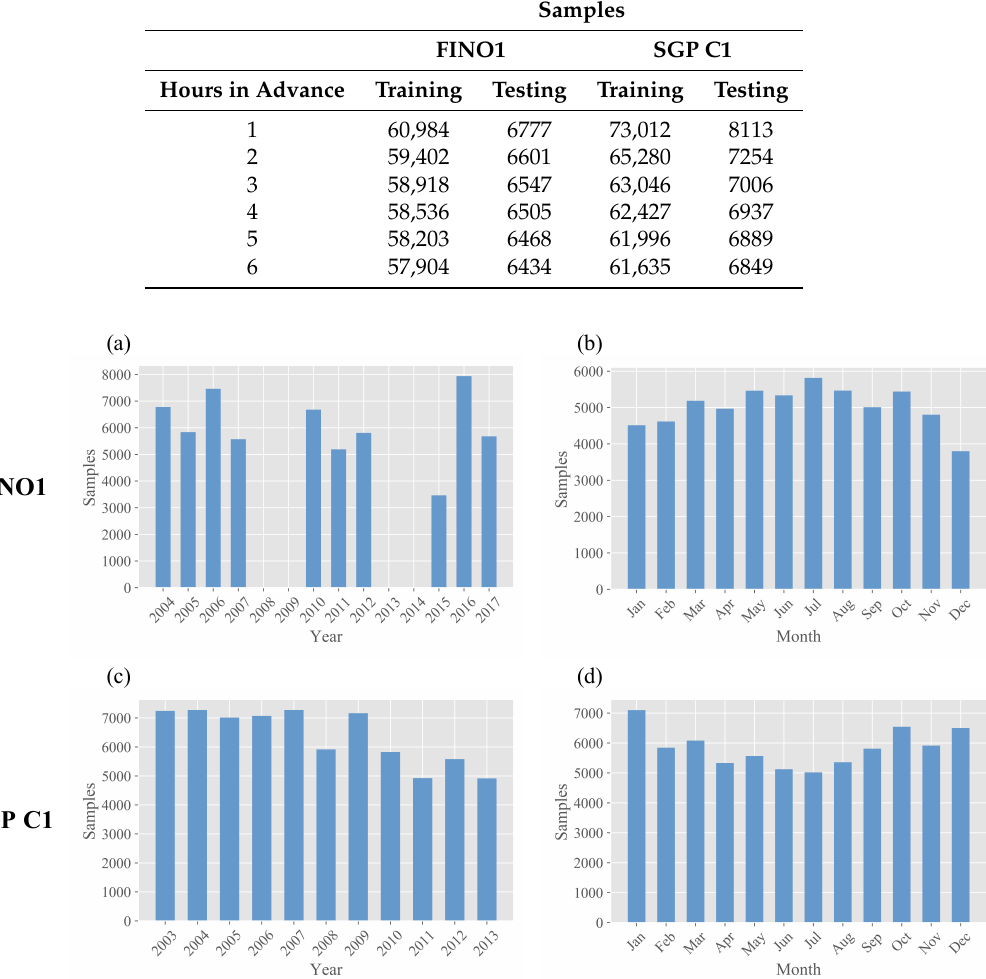
Figure A1. ( a,c ) Annual and ( b,d ) monthly training data availability for the FINO1 (top row) and SGP C1 (bottom row) datasets for a one-hour forecast. The amount of training data changed with the number of hours forecasted in advance, but all tests (except those testing the effects of reduced training data) had over 57,000 training samples and 6400 testing